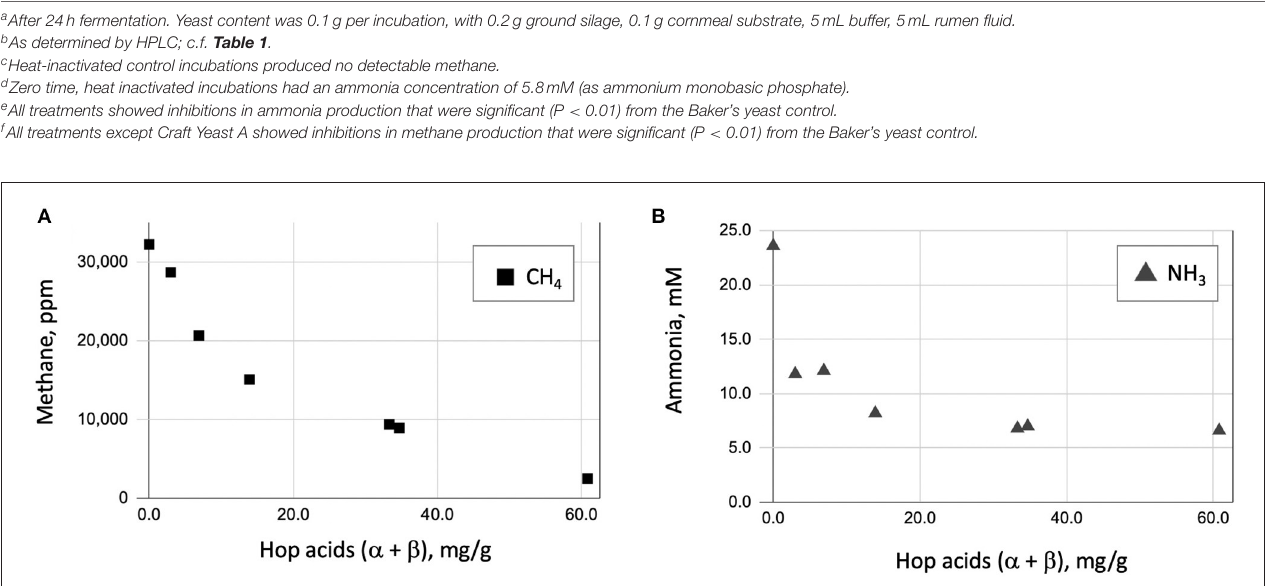
concentration, mM d